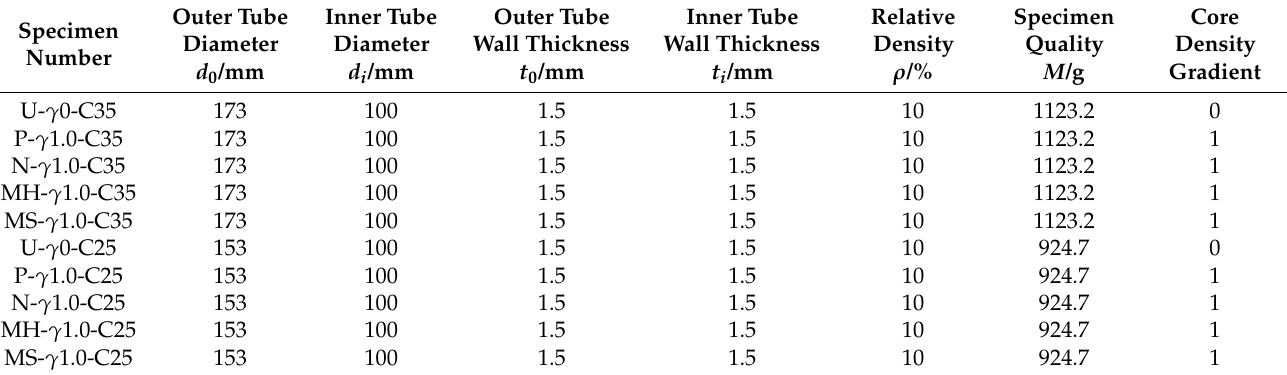
Table 4. Geometric parameters of aluminum foam sandwich tubes with different